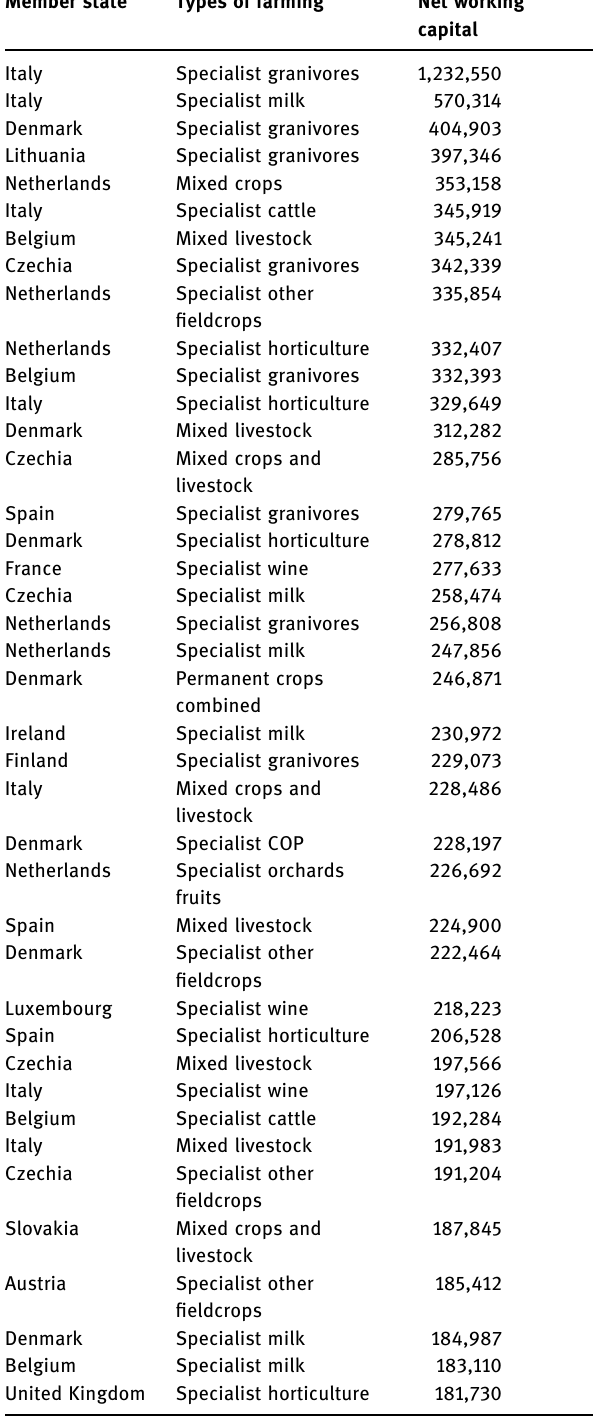
Table 3: Top40 European Union countries ( former 28 ) and types of farming for the net working capital ( euros ) on average over the